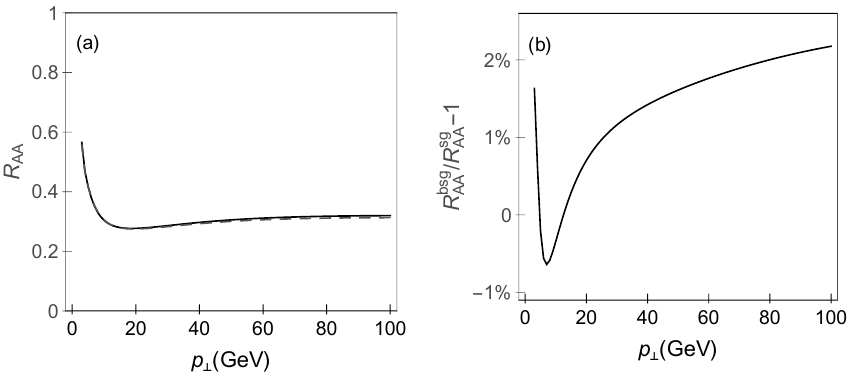
Figure 2. ( a ) The effect of a finite x on R AA as a function of final p ⊥ . The full (dashed) curve corresponds to the bsg ( sg ) case. ( b ) provides a percentage of R AA change when the sga is relaxed. Adapted from